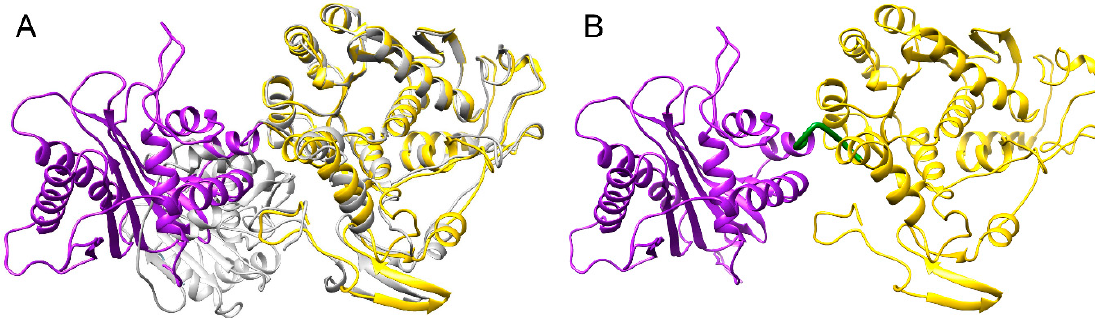
Figure 4. Template-based structure modeling of pUL15. ( A ) Superimposition of pUL15 domains onto the template structure. A superimposition of 4iox (purple) and 2o0j (yellow) onto 3cpe (gray) was used to create the pUL15 model shown in ( B ). A hinge region linking the two domains of pUL15 is colored in green.